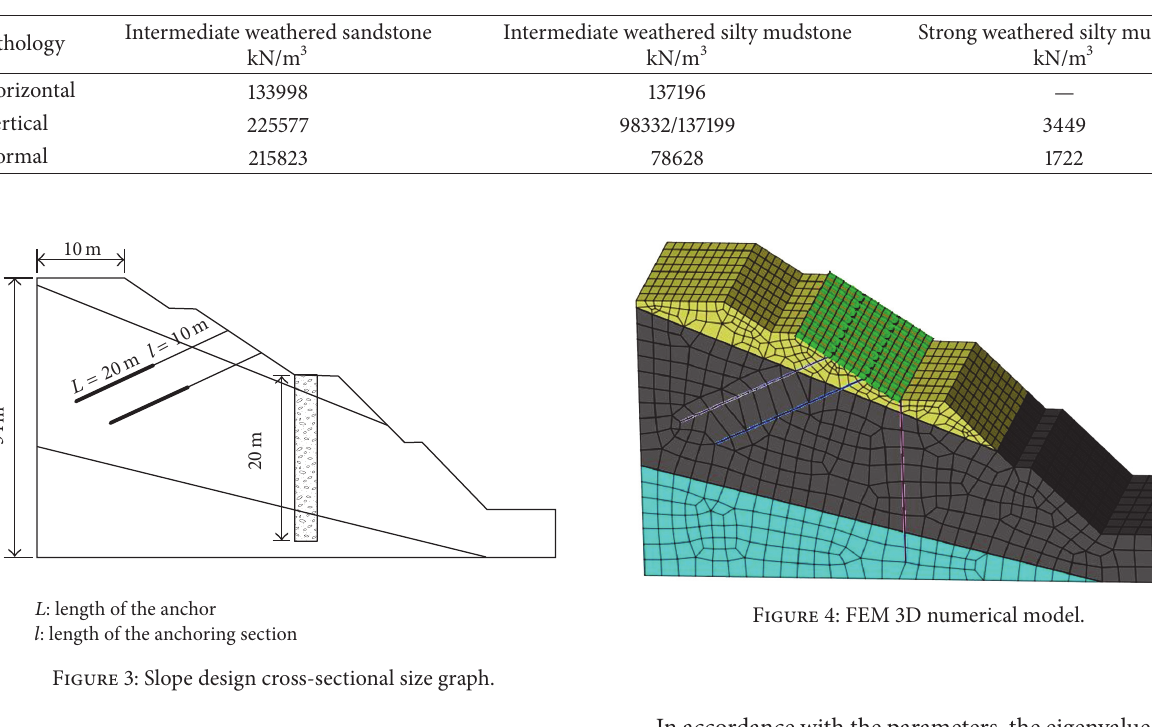
Figure 2: Sectional drawings of K27 slope. Table 2: Foundation reaction coefficient of every stratum.